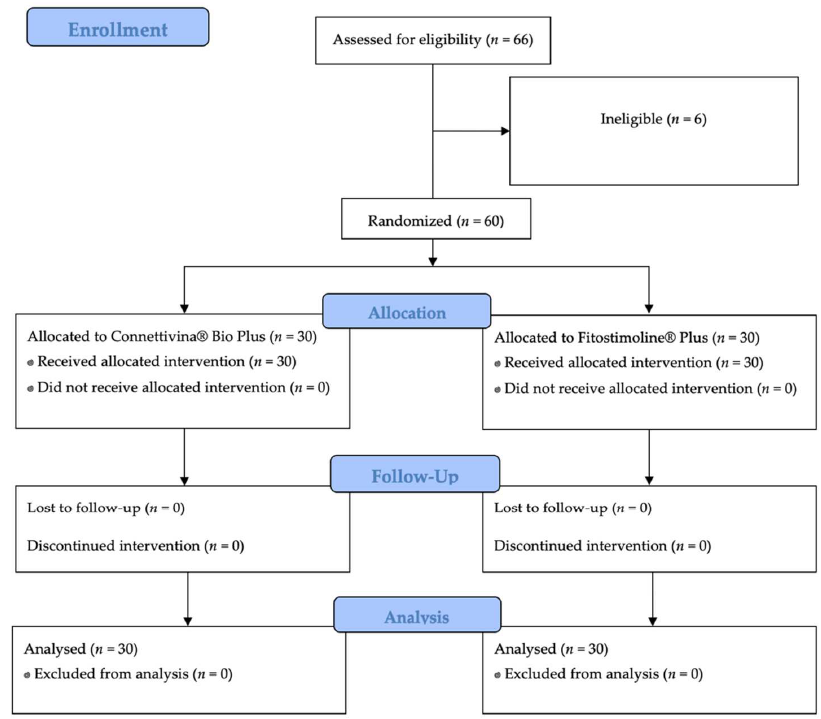
Figure 1. Schematic flowchart of the